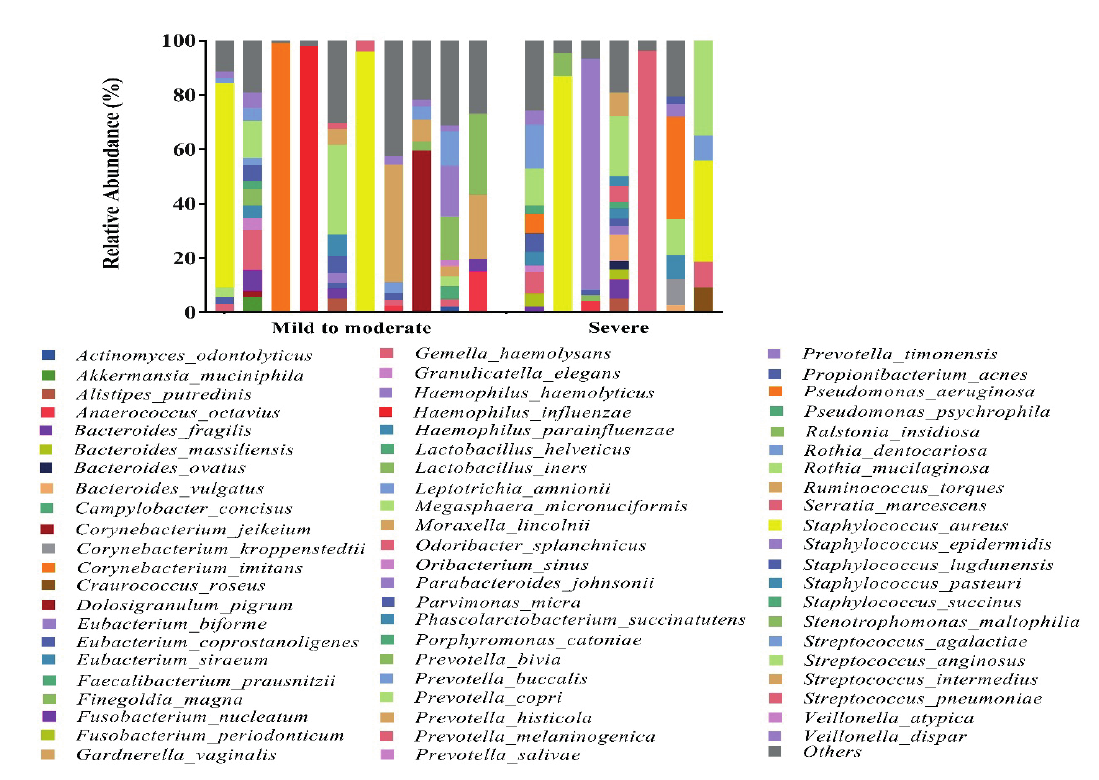
Figure S3. Main bacterial species found in middle meatus samples in each patient. Pseudomonas aeruginosa, Staphylococcus aureus and Fusobacterium nucleatum were present in both disease state.